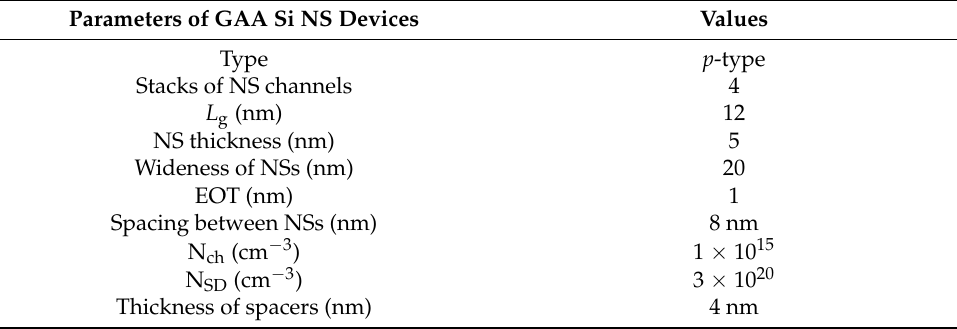
Figure 10. ( a ) Simulated GAA Si NS device’s structure and cross-sectional images ( b ) perpendicular to and ( c ) along the channel direction. Table 1. Parameters defined in stacked GAA Si NS